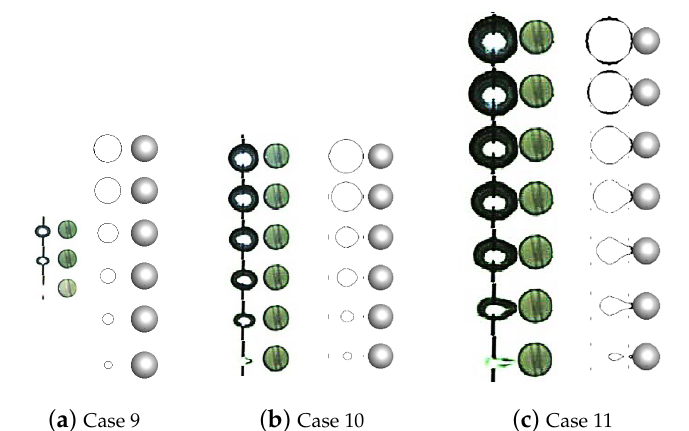
Figure 6. The comparisons of profiles of collapsing bubbles under the influence of static particles from experimental (left) and numerical (right) results.